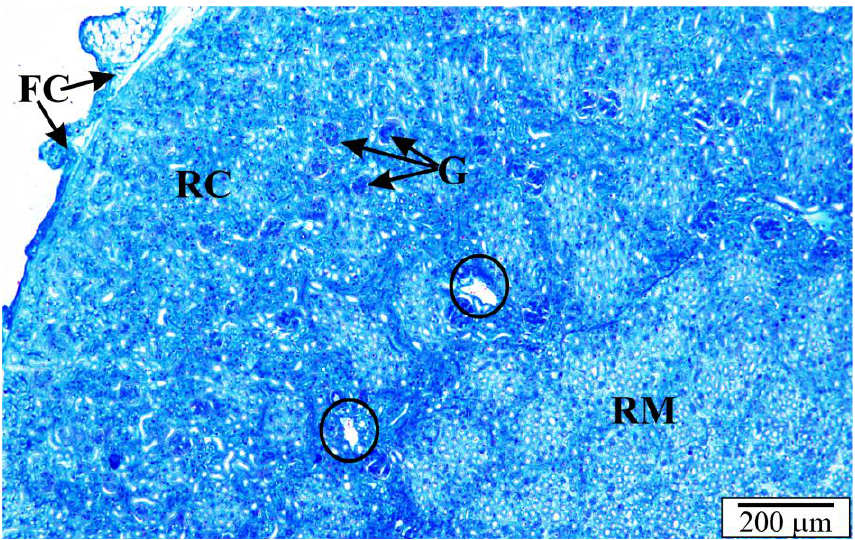
Figure 3. Section through the kidney of a rat with congenital babesiosis. FC—fibrous capsule, G—renal corpuscles, RC—renal cortex, RM—renal medulla, circular markings—extended spaces.